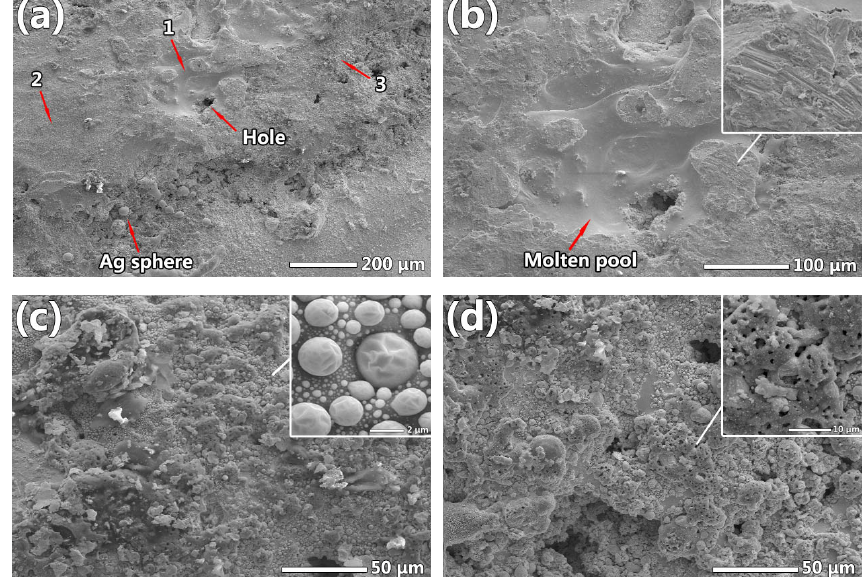
Fig. 4 Representative microstructures of the eroded area on the contact surface of Ag/10TSC. (a) Surface of the Ag/10TSC contact. (b) Amplified image of area 1, and the inset shows the broken Ag with arc marks. (c) Enlarged image of area 2, and the inset shows the sagged Ag particles. (d) Enlarged image of area 3, and the inset shows the spongy Ag.